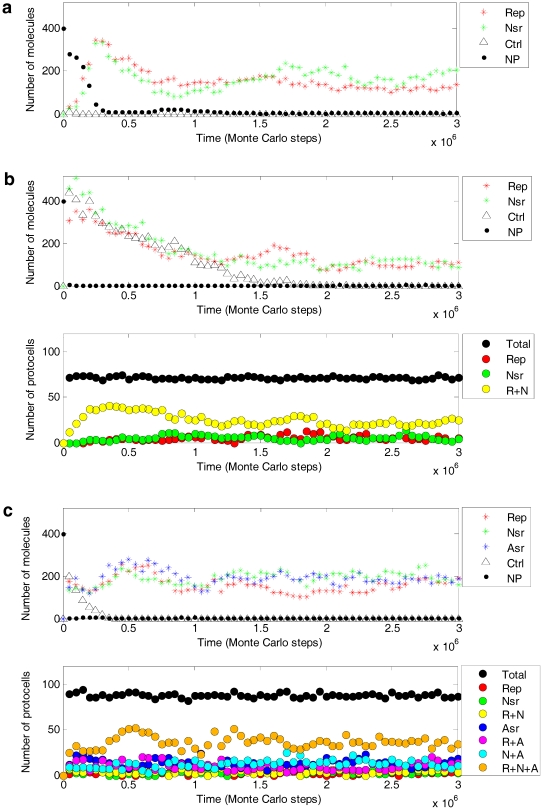
Co-spread of the ribozymes in a larger scale system.The characteristic domain for a ribozyme or the control RNA species is a stem-loop “X8∼X1LLLLY1∼Y8”, i.e., the domain has a length of 20 nucleotides. Nucleotide precursors (dots) are represented in a 1/400 scale relative to the number of the ribozymes (e.g., 400 denotes 1.6×105). The manner of inoculating ribozymes (/protocells) and the figure symbols are the same as those used in Fig. 3. For the naked stage (a), TNPB = 1.6×105, PNDE = 5×10−5, PAT = 0.3, PFP = 5×10−3, PFLR = 0.05, and the values of the other parameters are the same as in Fig. 3a. For the pseudo-protocell substage (b) and the true-protocell substage (c), TNPB = 1.6×105, LAM = 600, PNDE = 5×10−5, PAT = 0.3, PFP = 5×10−3, PFLR = 0.05, PMV = 0.5, PADM = 5×10−5, PALM = 5×10−5, PNPP = 0.1, PAPP = 0.2, PCB = 5×10−6, PCF = 1×10−4, PCD = 0.01, PMC = 0.05, FSI = 2, and the values of the other parameters are the same as in Fig. 3b and c.